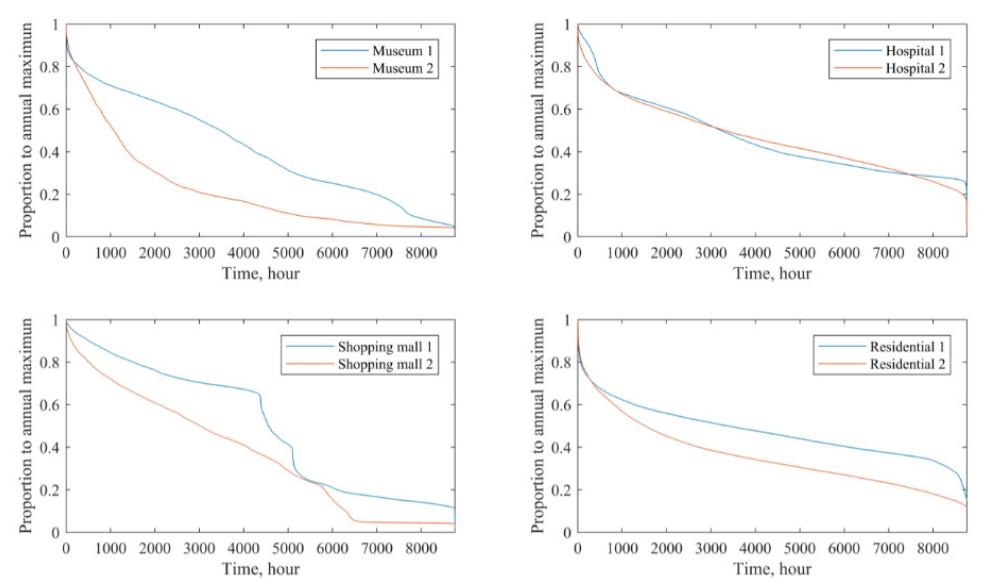
Figure A1. Annual 8760-h power load of the museums, hospitals, shopping malls and residentials building.